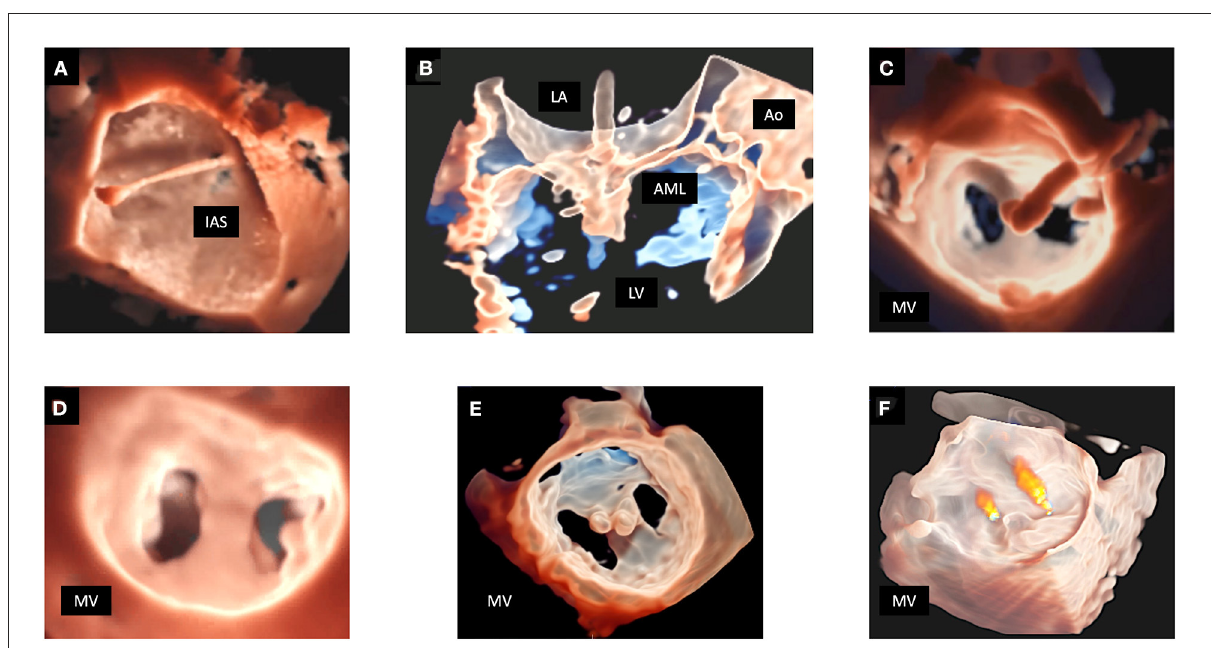
FIGURE7 MitraClip procedure monitoring in a patient with MV prolapse. In (A) TI allows a detailed depiction of the trajectory across the interatrial septum into the left atrium. In (B) the “transparency” effect clearly shows the capture of the MV leaflets by the clip. In (C) TI rendering enhances the visualization the clip before deciding for its release. The lower panels show the result of the procedure. 3D MV reconstruction is displayed by TI rendering from the LA perspective (D) , and from the LV perspective with the application of the “transparency” effect, clearly showing 2 clips implanted in the correct position (E) . In (F) the residual regurgitant jets are displayed in a 3D reconstruction of the MV with the “transparency” effect and superimposed color Doppler. 3D, three-dimensional; AML, anterior mitral leaflet; Ao, aorta; IAS, interatrial septum; LA, left atrium; LV, left ventricle; MV, mitral valve; TEE, transesophageal echocardiography; TI, transillumination. TTE, transthoracic